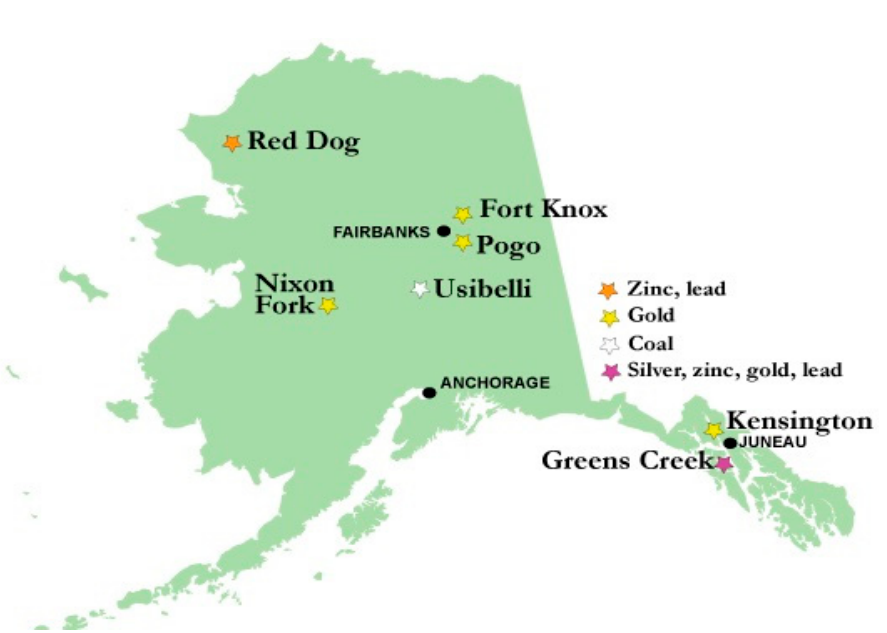
Figure 3. Map showing the location of different mine sites in Alaska and the respective deposits [34].